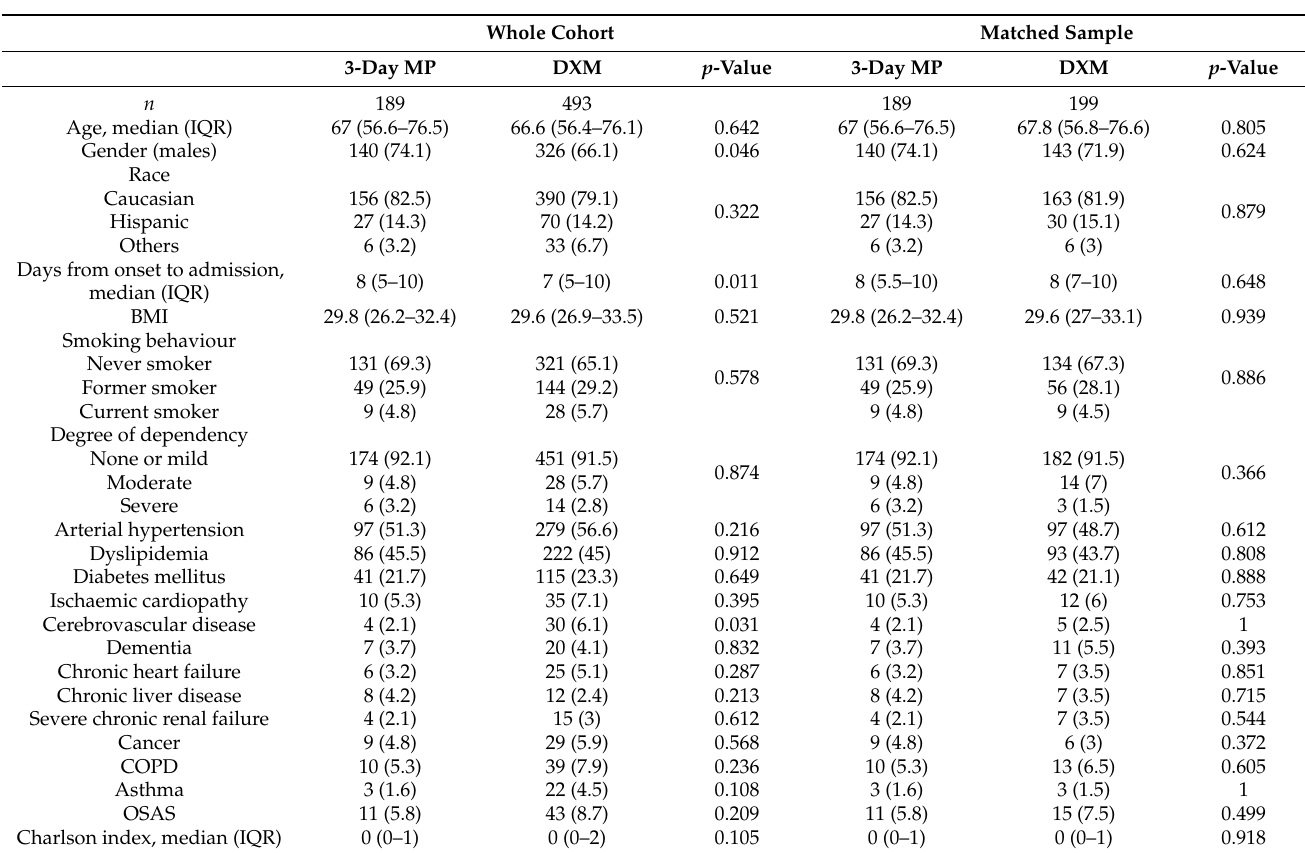
Table 1. Comparison of demographic and comorbidity data between groups.